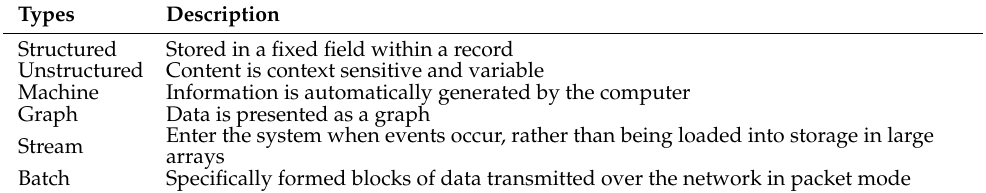
Table 4. Basic data